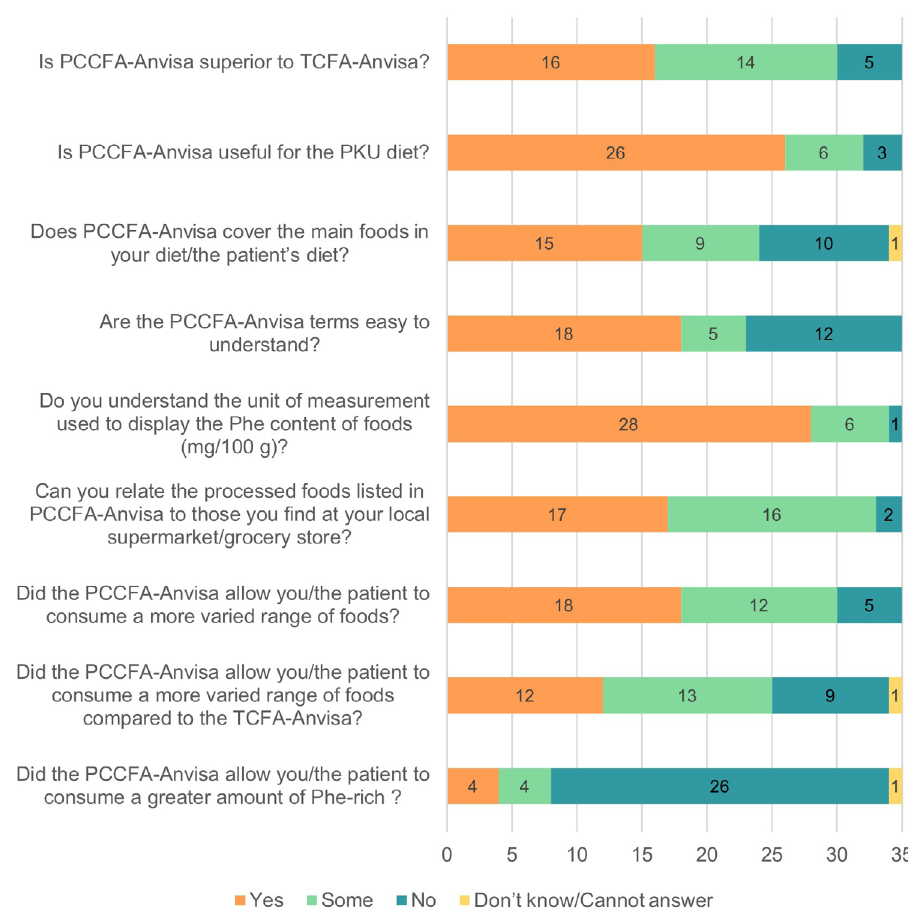
Figure 3. Perception and understanding of patients with PKU, their family members, and caregivers regarding the Anvisa tools for determining Phe content of foods and the impact of these resources on their PKU diet (n=35) PCCFA-Anvisa: Phenylalanine Content of Foods Dashboard ( Painel para Consulta do Conteúdo de Fenilalanina em Alimentos ); TCFA-Anvisa: Table of Phenylalanine Content of Foods ( Tabela de Conteúdo de Fenilalanina em Alimentos ); PKU: Phenylketonuria; Phe: